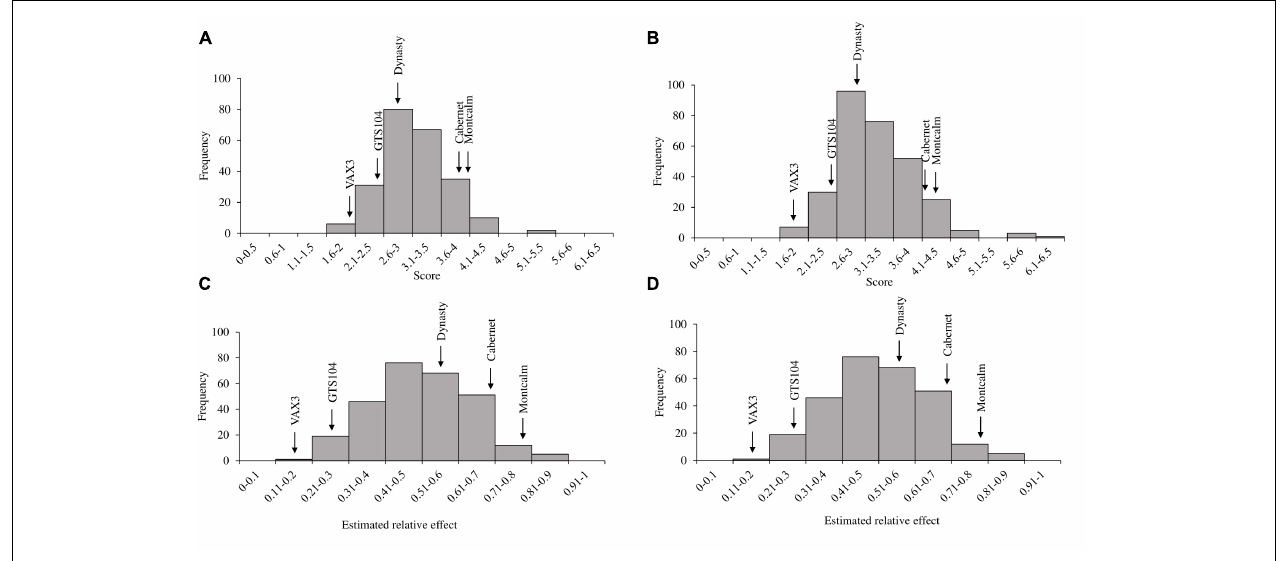
Frontiers in Plant Science |